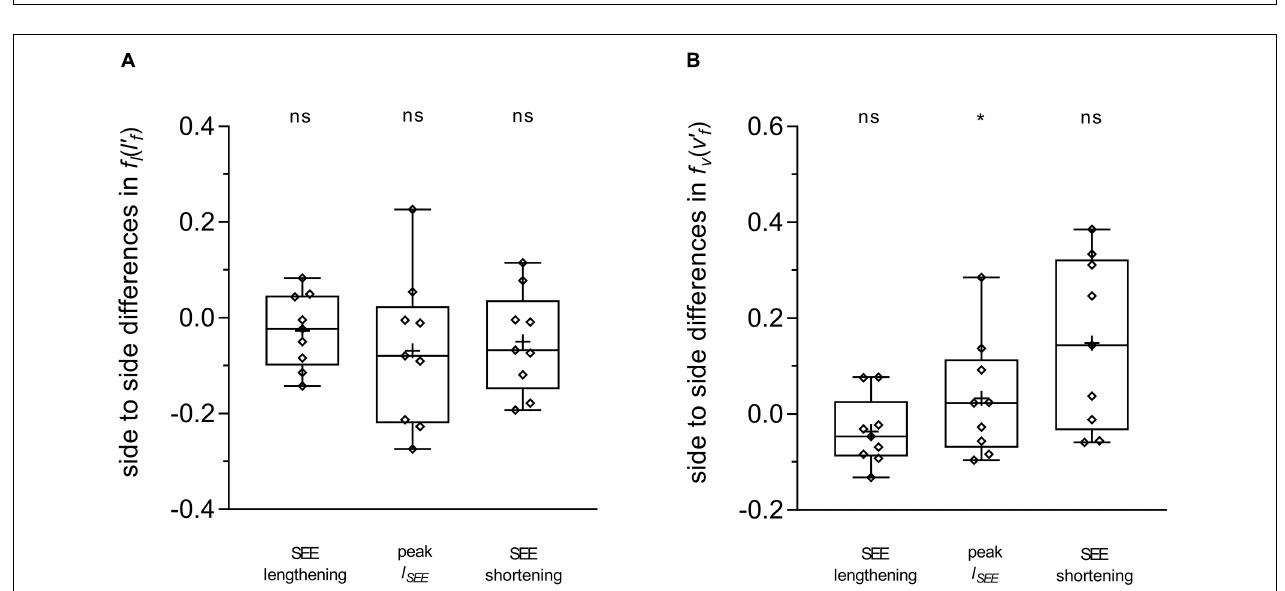
FIGURE 5 | Differences between the affected and unaffected legs in gastrocnemius medialis length-dependent [ f l ( l (cid:48) f ) ] (A) and velocity-dependent [ f v ( v (cid:48) f ) ] (B) force potential. Statistical testing was run on average values during the series elastic element (SEE) lengthening and shortening sub-phases, and on single data points at peak SEE length ( l SEE ). The lower and upper parts of the box plots represent the first and third quartile, respectively. The length of the whisker delineates the minimum and maximum values. The horizontal line in the box represents the median of the sample; +, sample mean; * p < 0.05, significant side-to-side difference; ns: